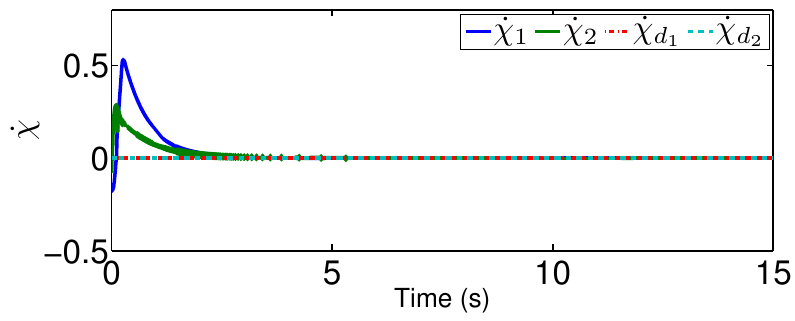
Figure 9. Performance χ under the proposed